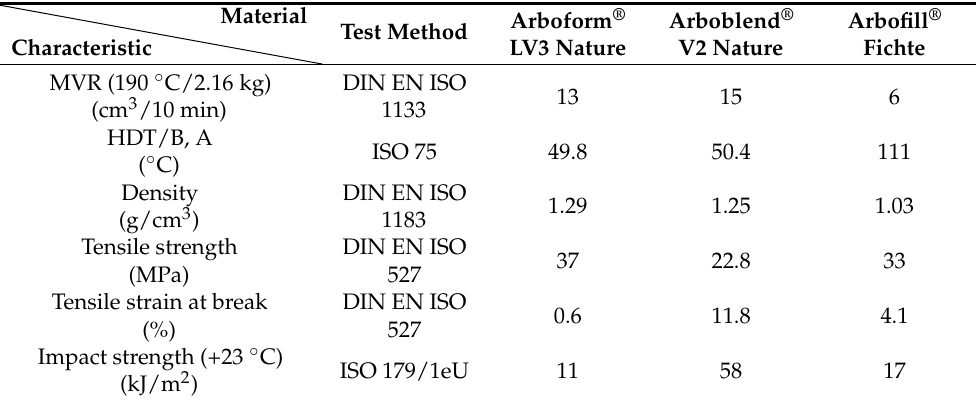
Table 1. Main characteristics/properties of the studied materials [8–10].